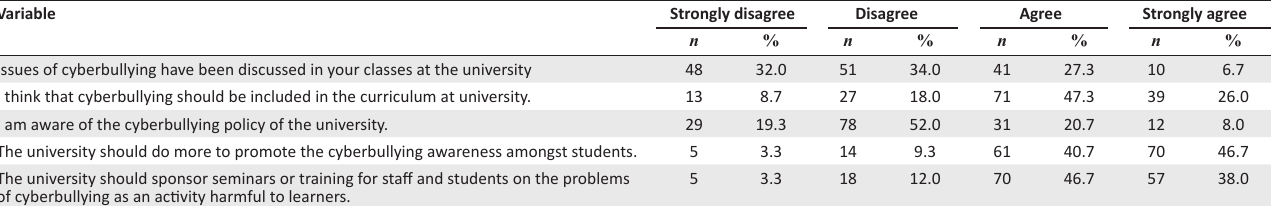
TABLE 6: Prevention of